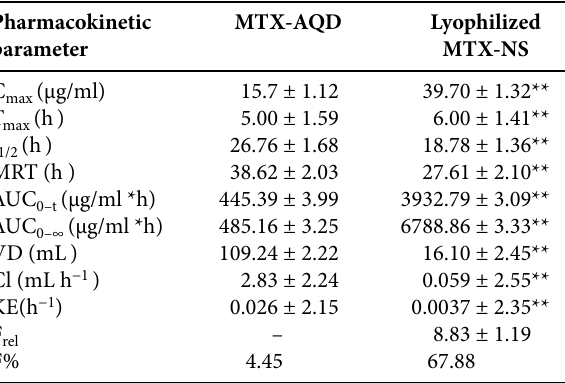
Table 7. Plasma pharmacokinetic parameters of MTX-AQD and Lyophilized MTX-NS in Sprague Dawley rats after oral administra-